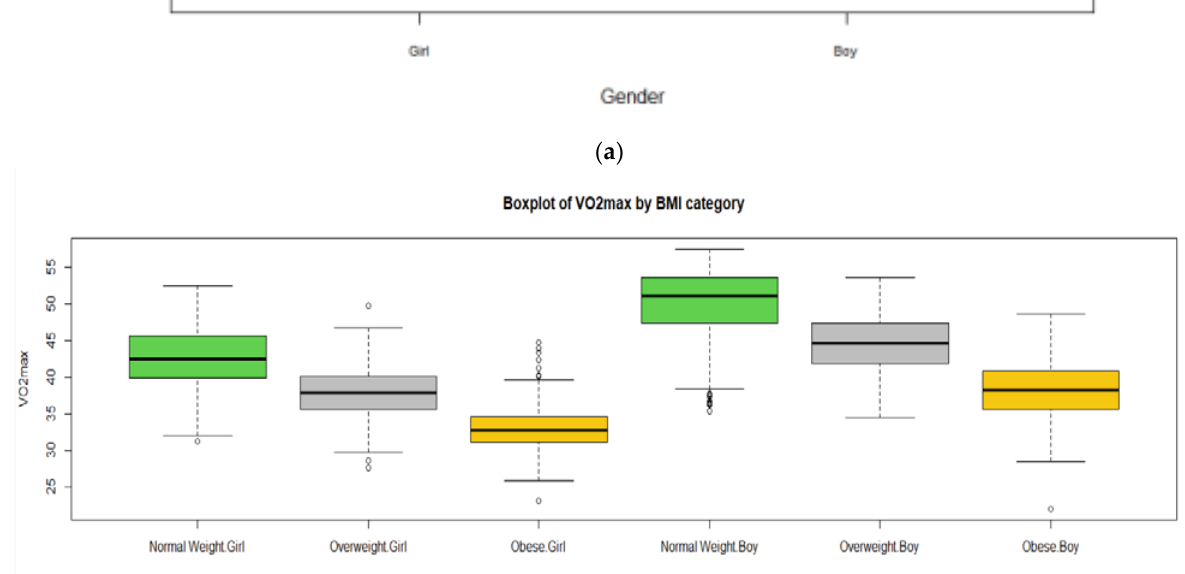
Figure 2. Boxplot of VO 2 max by gender ( a ) and by BMI category ( b ).